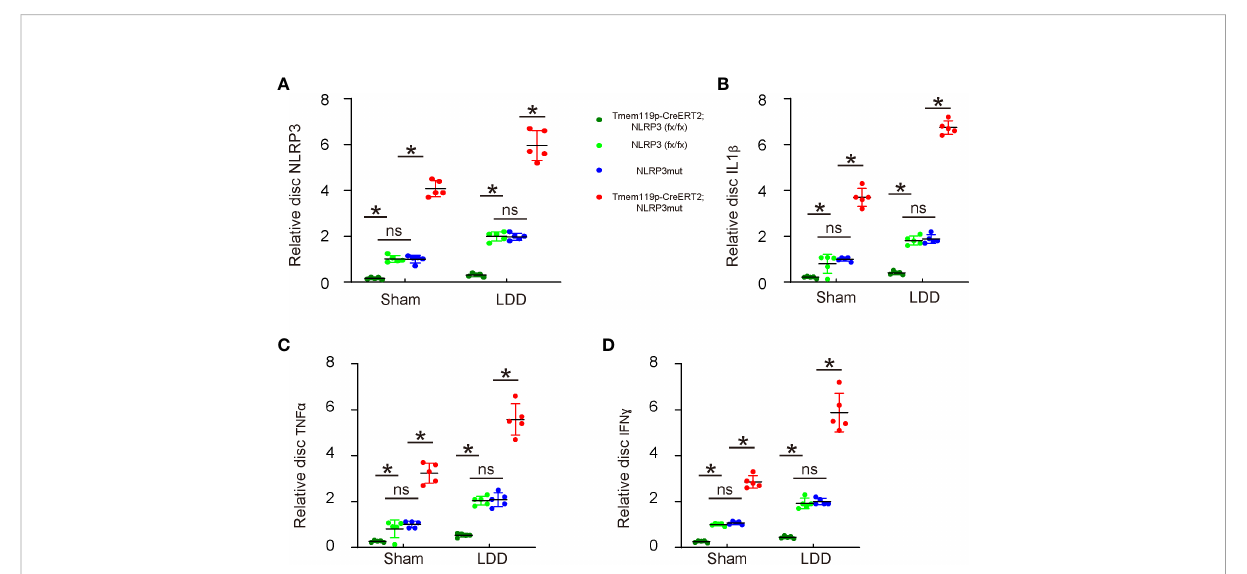
FIGURE 6 Reduction in disc degeneration and associated pain by NLRP3 depletion in microglia may result from an alleviation of neuroin fl ammation. (A – D) ELISA for NLRP3 (A) , IL-1 b (B) , TNF a (C) and IFN ɣ (D) levels in disc tissue sham/LDD-treated mice. The relative levels to those from NLRP3mut (=1) were shown. *p<0.05. ns, no signi fi cance.